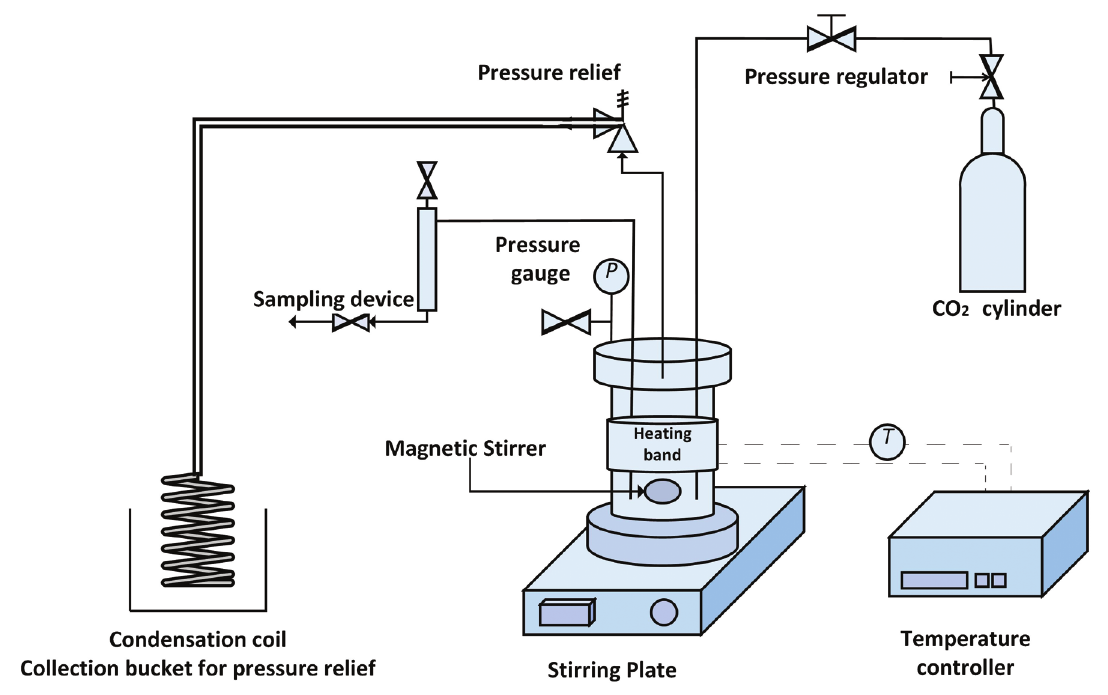
Figure 3: Schematic diagram of the semi-batch reactor used for styrene carbonate (SC) formation.